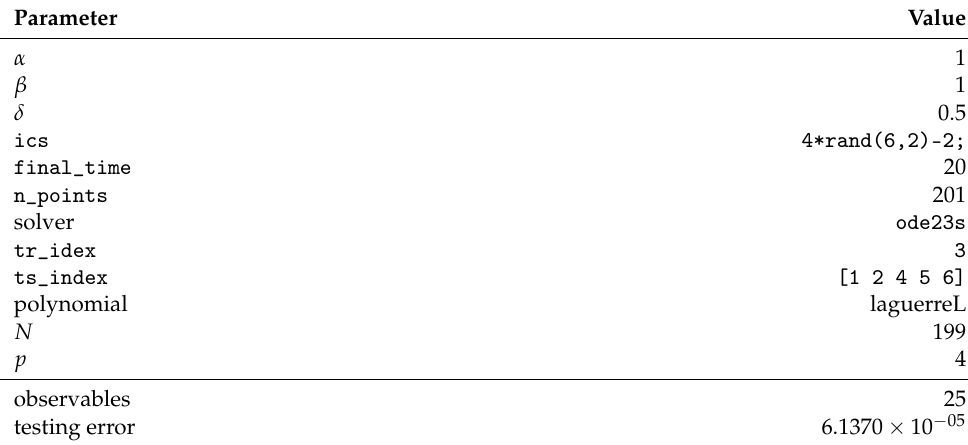
Table 1. Approximation parameters for the hard spring Duffing